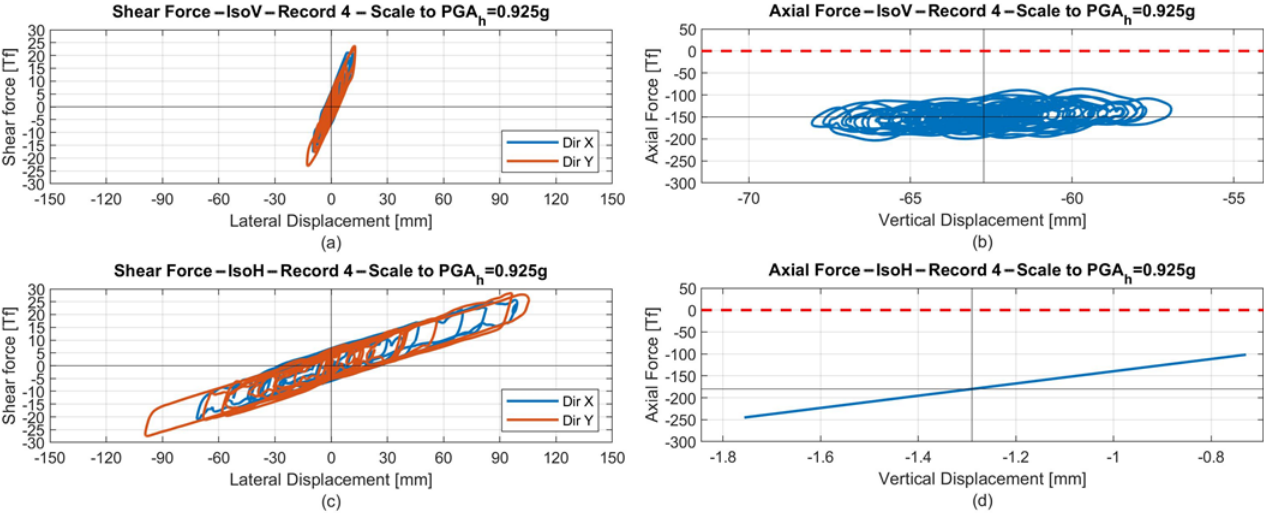
Figure 10. Force–displacement hysteresis for the scaled Record 4. ( a ) IsoV horizontal direction “X” response. ( b ) IsoV vertical direction “Z” response. ( c ) IsoH horizontal direction “X” response. ( d ) IsoH vertical direction “Z” response.